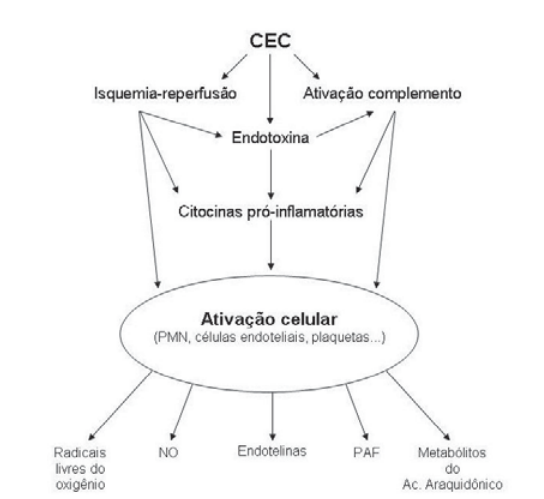
Fig. 3 - Representação esquemática da resposta inflamatória gerada pela circulação extracorpórea (Adaptado de Wan et al. 1997)